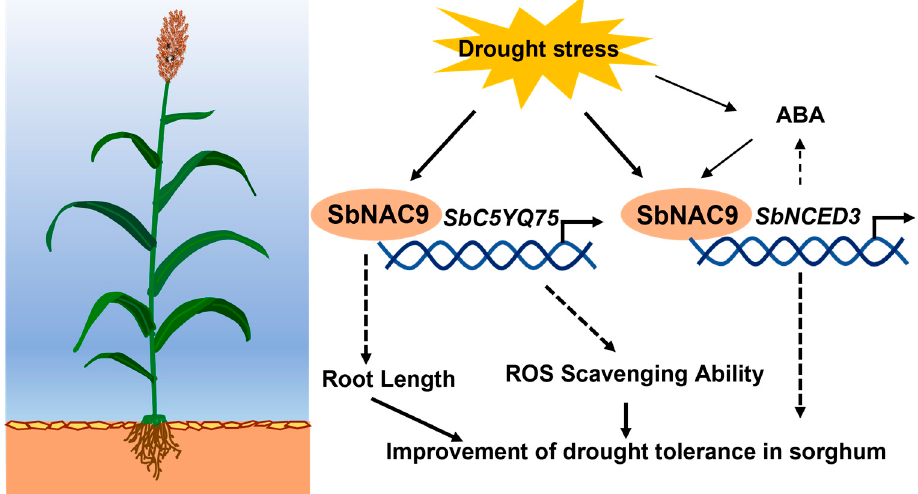
Figure 7. Model for SbNAC9 function in drought-stress tolerance of sorghum. Drought stress induces SbNAC9 expression. SbNAC9 directly activates the expression of SbC5YQ75 and SbNCED3 by binding to their promoters. In addition, SbNCED3 may potentially promote biosynthesis of ABA, which can induce SbNAC9 expression to form a feedback regulation. Additionally, SbNAC9 overexpression enhances drought-stress tolerance of sorghum through altering root architecture and increasing ROS scavenging ability.